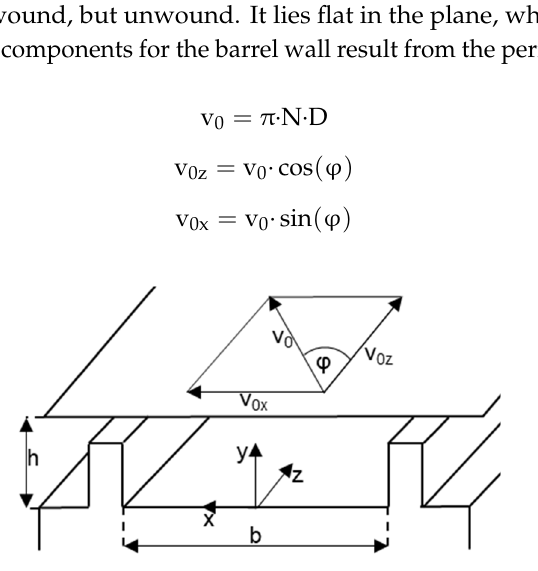
Figure 2. Kinematic reversal.